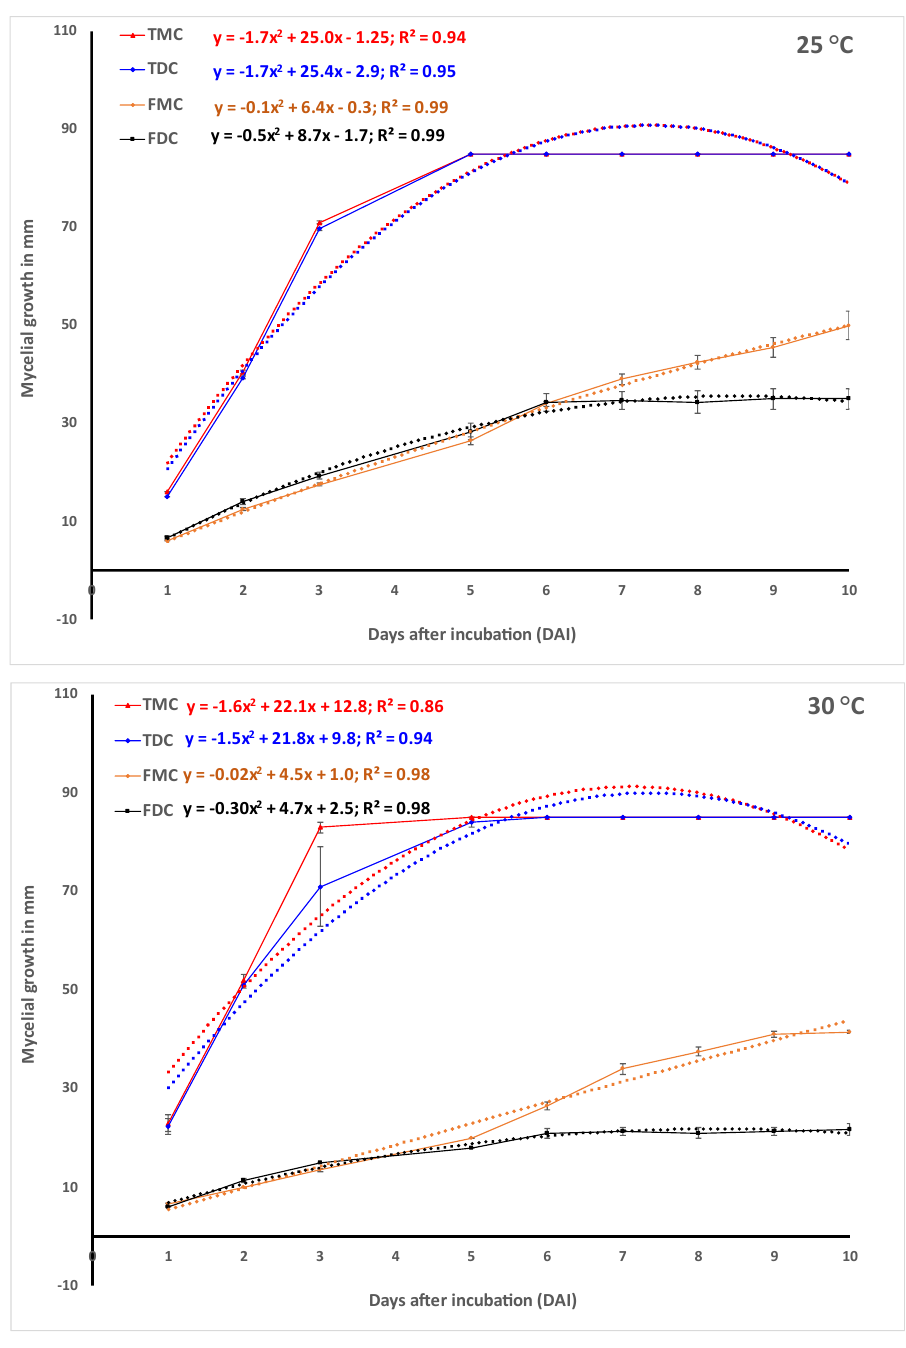
Figure 2. In vitro mycelial growth of the pathogen causing yellowing and rhizome rot of ginger Fusarium oxysporum f.sp. zingiberi and the beneficial fungus Trichoderma harzianum strain T-22 in monocultures (FMC, TMC) or dual cultures (FDC, TDC) on potato dextrose agar (PDA) medium incubated at 20, 25 and 30 °C. The continuous lines are the actual data points and the dotted lines represent predicted data according to a second-degree polynomial function. T reatment means for the AUMGC separated using Tukey’s test at p < 0.05 level is presented in Figure 3. The trichoderma strain in this study Th-22 grew significantly faster in monoculture and in dual culture than Foz when incubated at 30 or 25 °C in both PDA and APDA (Figure 3). The growth of Th-22, however, was significantly lower when incu- bated at 20 °C irrespective of the culture media. In contrast, Foz grew significantly lower at all levels of temperature and culture medium and the four treatment combinations when compared with the growth of Th-22 (Figure 3). At 30 °C, percent inhibition of growth 10 days after incubation on Foz was 47.8% and 40.2% on PDA and APDA, respec- tively (data not presented).